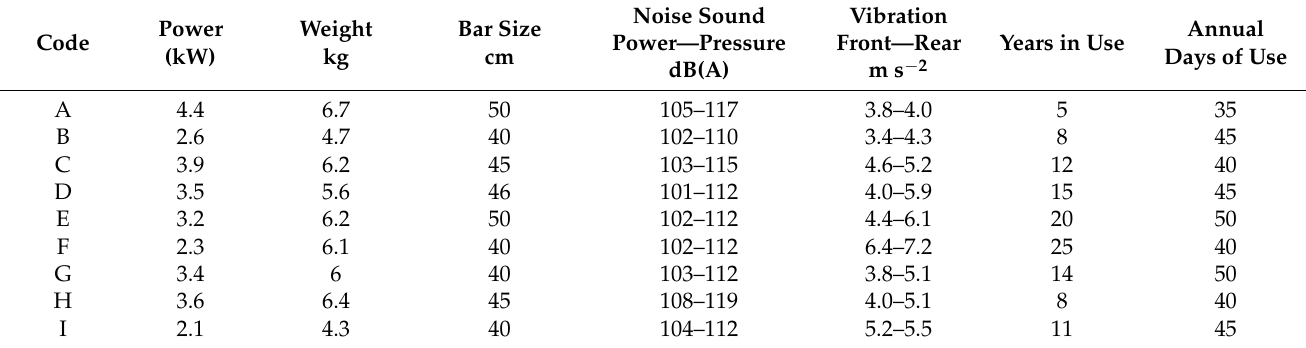
Table 1. Chainsaw characteristics and the values declared by